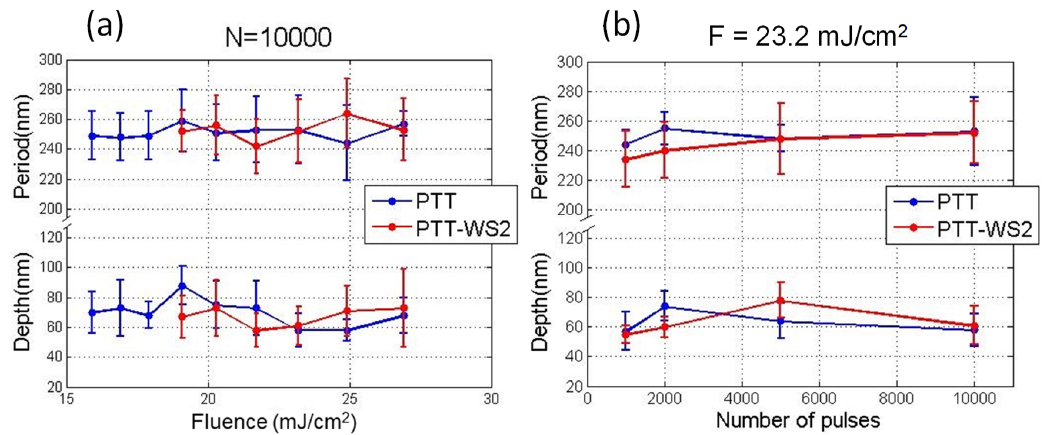
Figure 2. Dependence of LIPSS period and depth, on the number of pulses at a fluence of 23.2 mJ / cm 2 per pulse ( a ) and on the fluence at 10,000 pulses per irradiation ( b